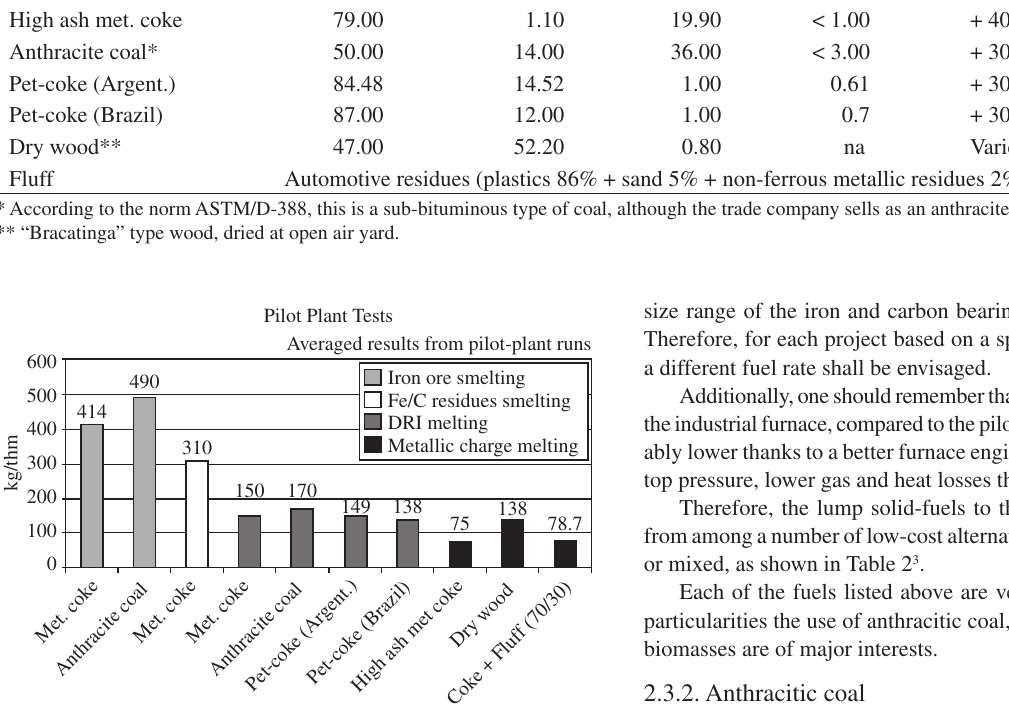
Figure 5. Fuel-rates for different ferrous